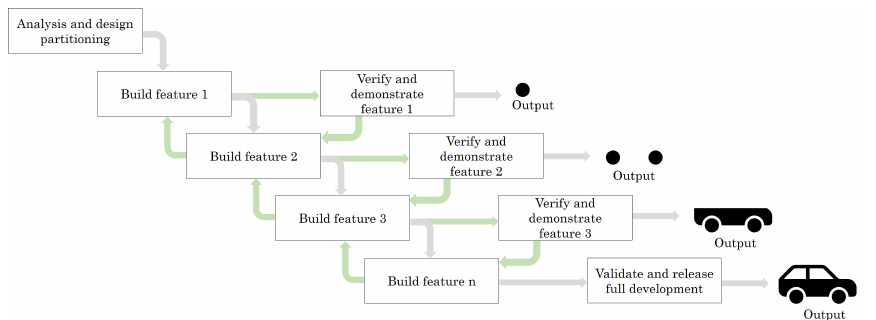
Figure 2. Incremental model and its